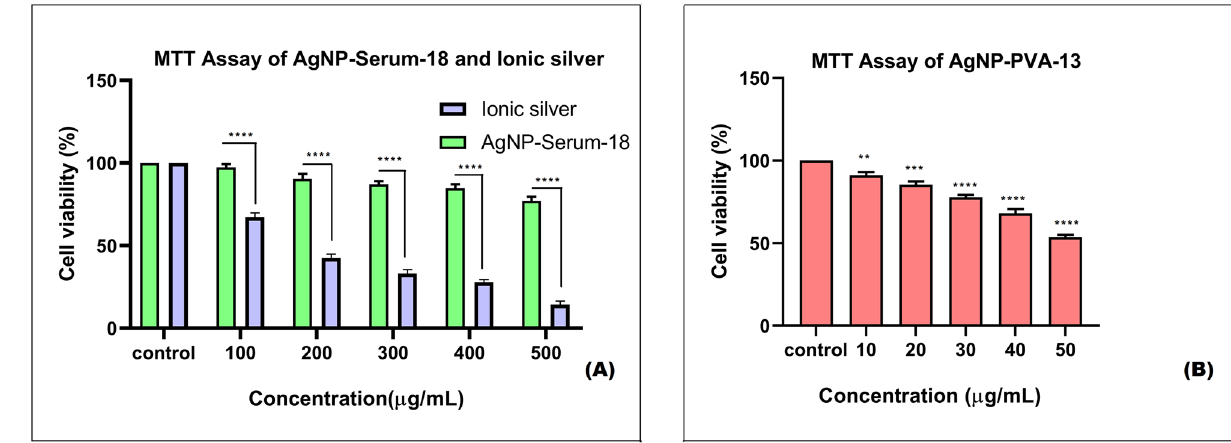
Figure 4. MTT Assay. ( A ) Normal liver cell line (WRL-68) with AgNP-Serum-18 and with ionic silver at equivalent concentrations as a control. ( B ) Normal liver cell line (WRL-68) with AgNP-PVA-13. Data are expressed as means ± SD. There was significant difference between the treated and control groups (** P < 0.01; ***P < 0.001; ****P <